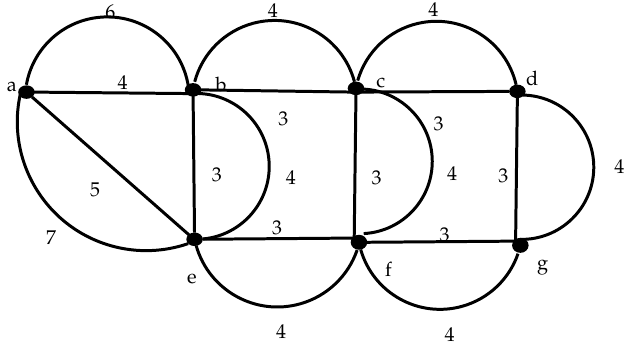
Figure 3. 7-node network example with